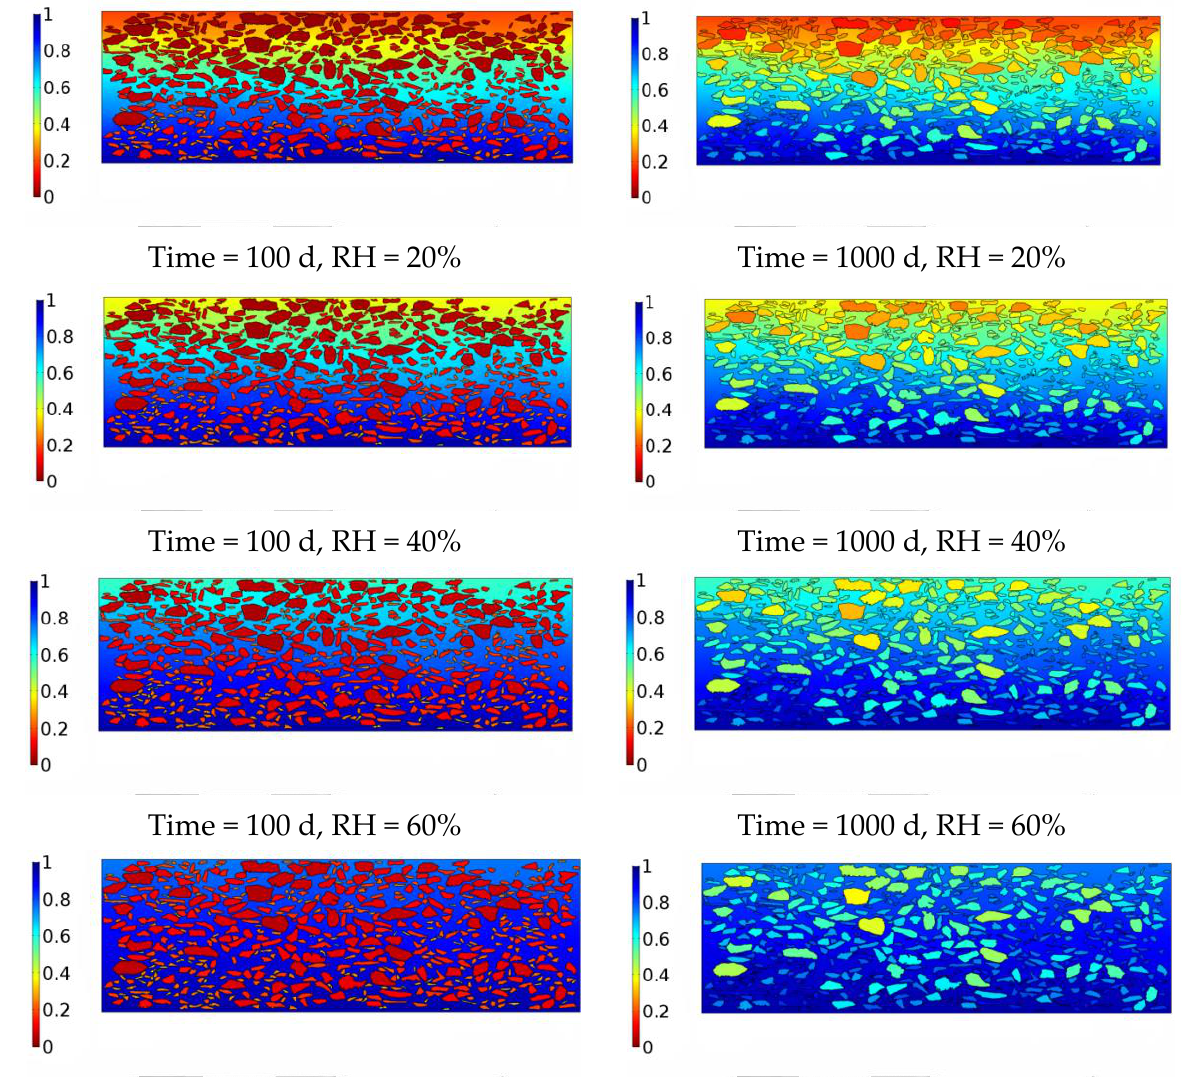
Figure 13. Volume relationships of the asphalt mixture.